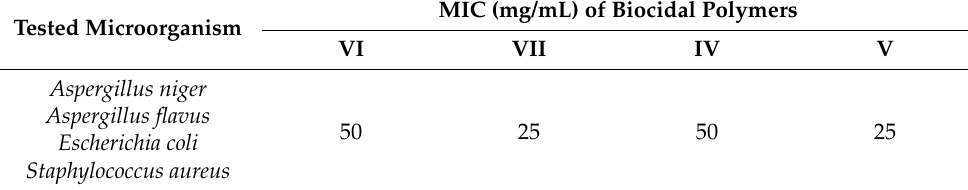
Table 4. Minimal inhibitory concentrations (MIC; mg/mL) of selected polymers against different susceptible microorganisms.